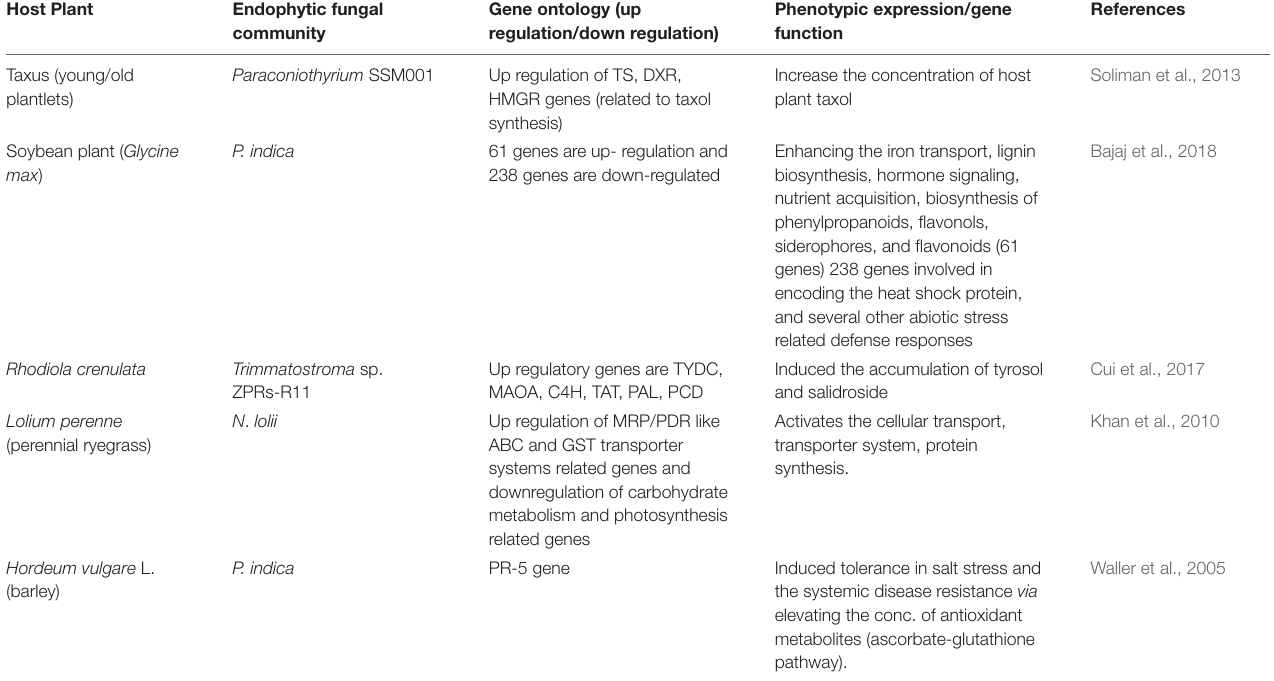
TABLE 3 | Selected examples of plant gene alteration in the presence of endophytic fungi (EFs) and their resulted beneficial